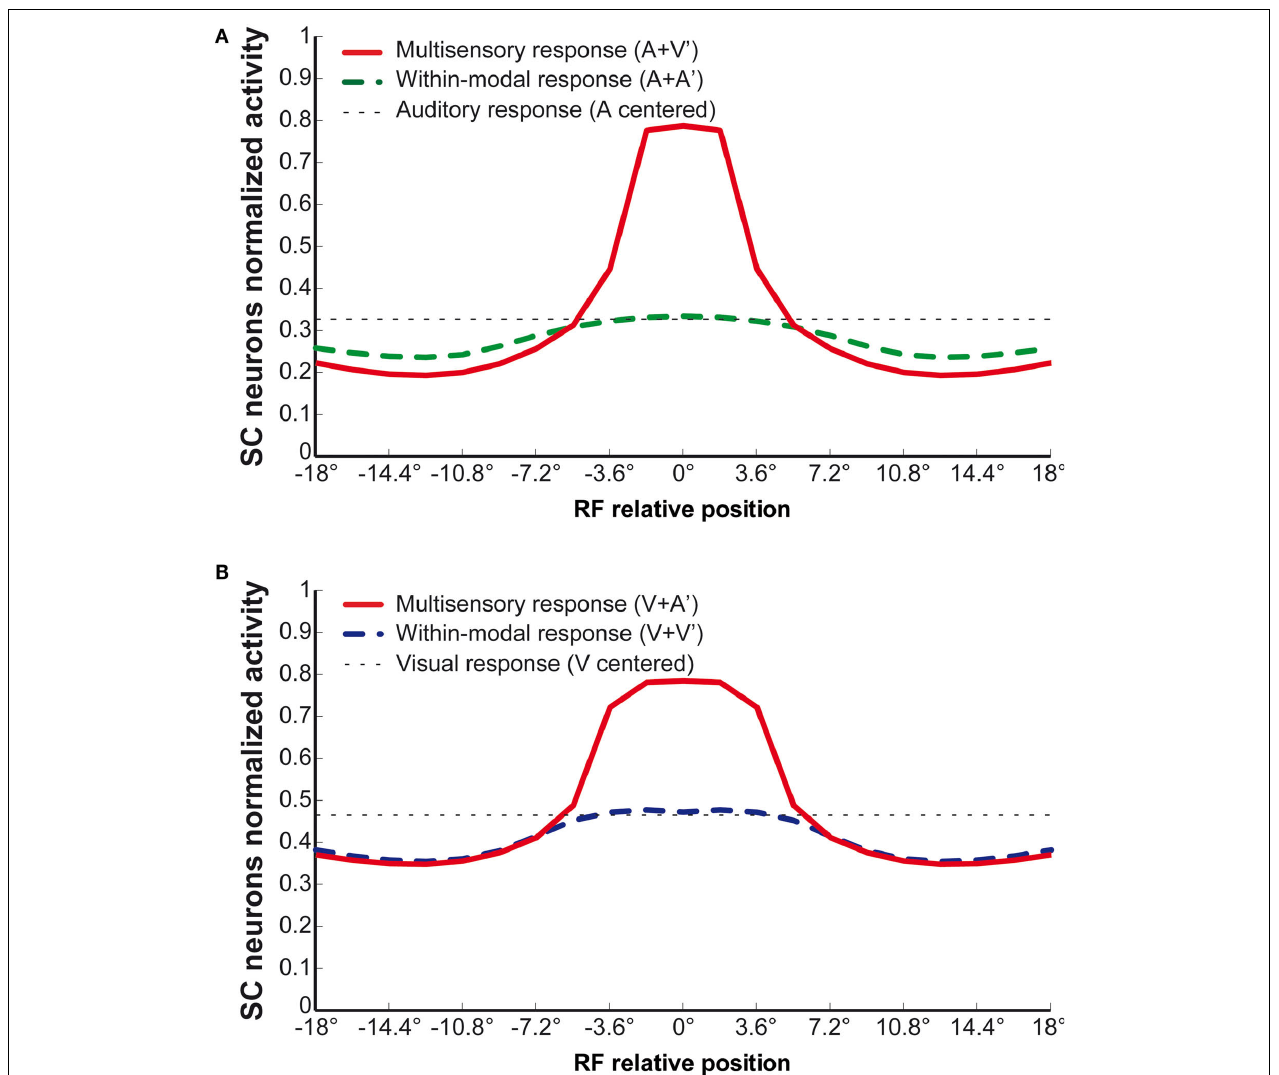
FIGURE 3 | Behavior of the intact network – Integration as a function of the position of two stimuli. The fi gures show the response of the intact network to paired stimuli in different spatial confi gurations. Simulations are made by stimulating the model with an auditory (A) or a visual (B) stimulus at the center of the RF of the observed SC neuron. The response elicited by this unimodal stimulus (dotted thin lines) is then compared with those produced by coupling either a second stimulus of the same sensory modality (dashed thick lines) or a stimulus of different sensory